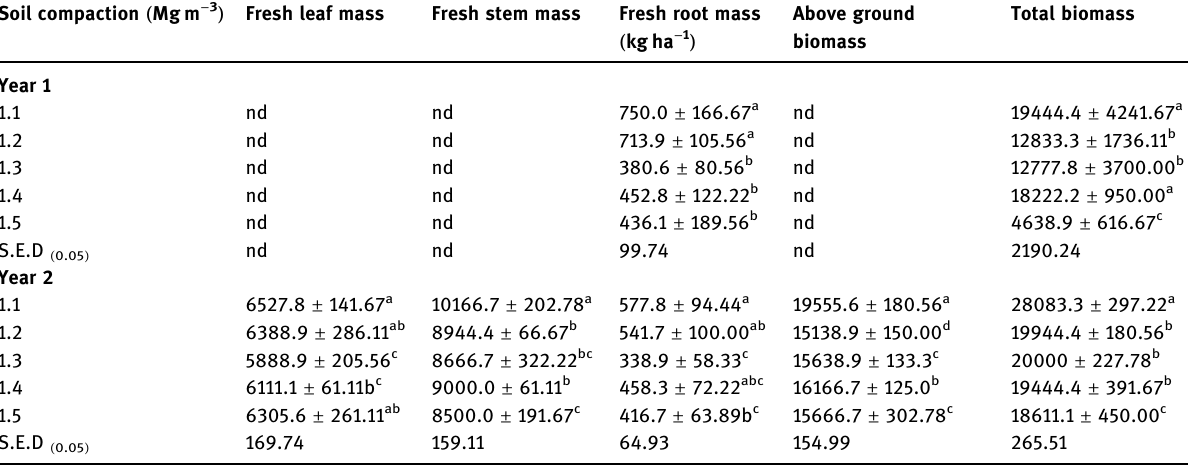
Table 3: E ff ect of soil compaction on fresh mass of groundnut growth parameters Soil compaction ( Mg m − 3 ) Fresh leaf